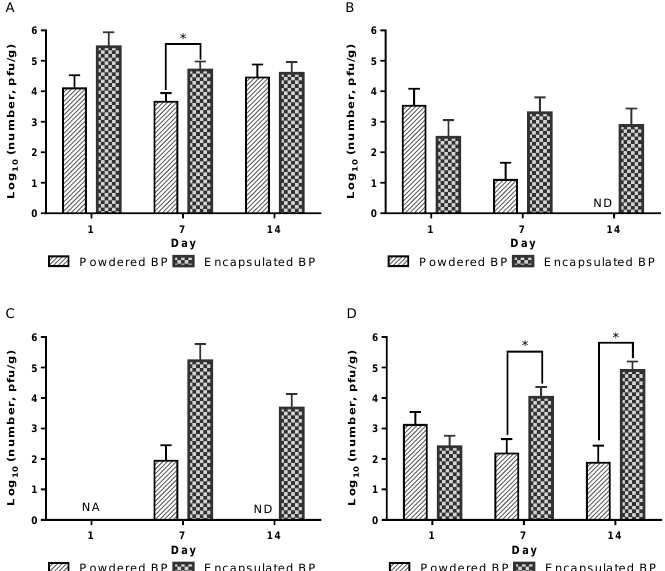
Figure 2. Viable BP levels in various segments of gastrointestinal tract. ( A ) Crop, ( B ) gizzard, ( C ) jejunum, and ( D ) cecum. Day-old broiler chickens were fed diets with or without encapsulated and powder BPs and sacrificed on different days for sampling gut digesta. Viable BPs ( Y -axis) in figures are presented in log 10 (pfu/g of digesta). Error bars represent the standard deviation of the mean. BPs were not detected in the no-BP-added diet-fed chickens (data not shown). Asterisks denote the significant differences in BP levels between the encapsulated and powder BP groups at the 0.05 level. NA = not assayed, ND = not detected.